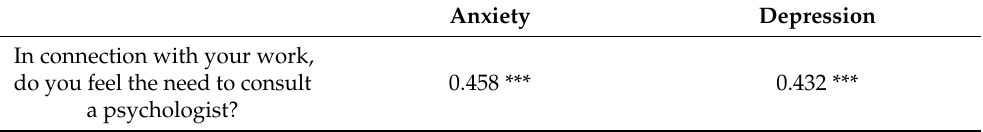
Table 7. Correlations between HADS scores and the need for consultation with a